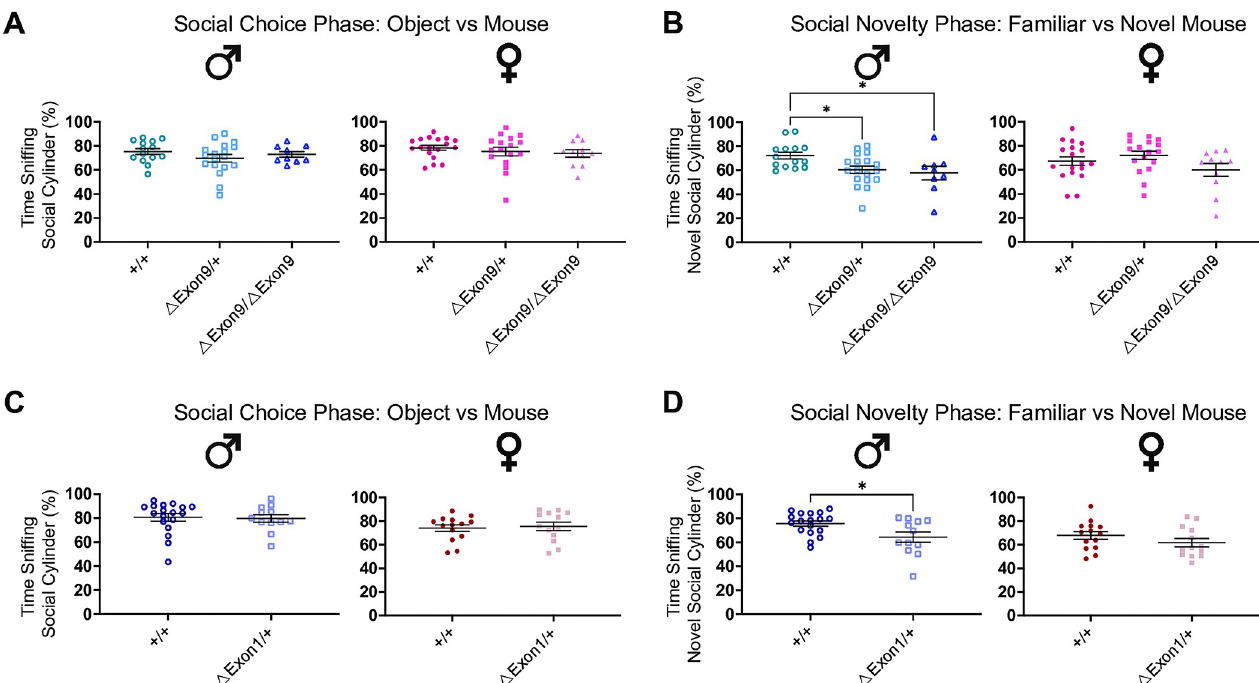
Fig 2. Reduction in Nrxn1 α expression impairs the preference for social novelty in male mice. A. No genotype difference was observed in time spent sniffing social cylinder among Δ Exon9 male (left) and female (right) mice in the social choice phase. B. Δ Exon9/+ and Δ Exon9/ Δ Exon9 male mice spend significantly less time than +/+ males sniffing the novel mouse (left), and no difference was found in females (right) in the social novelty phase. Male +/+, n = 14; male Δ Exon9/+, n = 18; male Δ Exon9/ Δ Exon9, n = 9; female +/+, n = 18; female Δ Exon9/+, n = 17; female Δ Exon9/ Δ Exon9, n = 11. Data were analyzed using one-way ANOVA test with Tukey’s multiple comparison test. C. No genotype difference was observed in time spent sniffing social cylinder among Δ Exon1 male (left) and female (right) mice in the social choice phase. D . Δ Exon1/+ male mice spend significantly less time than +/+ males sniffing the novel mouse (left), and no difference was found in females (right) in the social novelty phase. Male +/+, n = 18; male Δ Exon1/+, n = 12; female +/+, n = 14; female Δ Exon1/+, n = 13. Data were analyzed using the Mann-Whitney U test. For all panels in Fig 2, the data are represented as mean ± SEM; � p < 0.05.